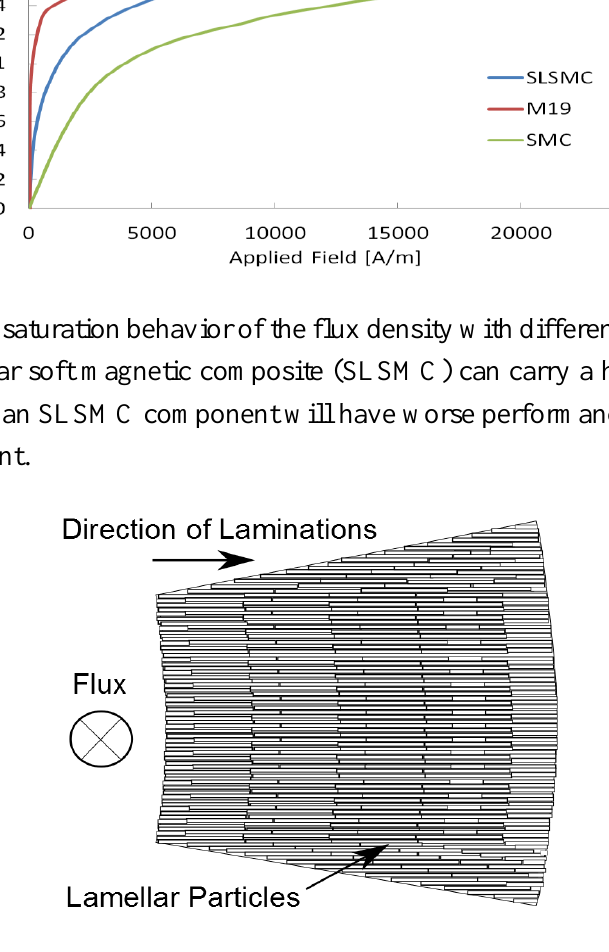
Figure 8. Lamellar particle orientation in an SLSMC. Segmented lamellar metal chips are